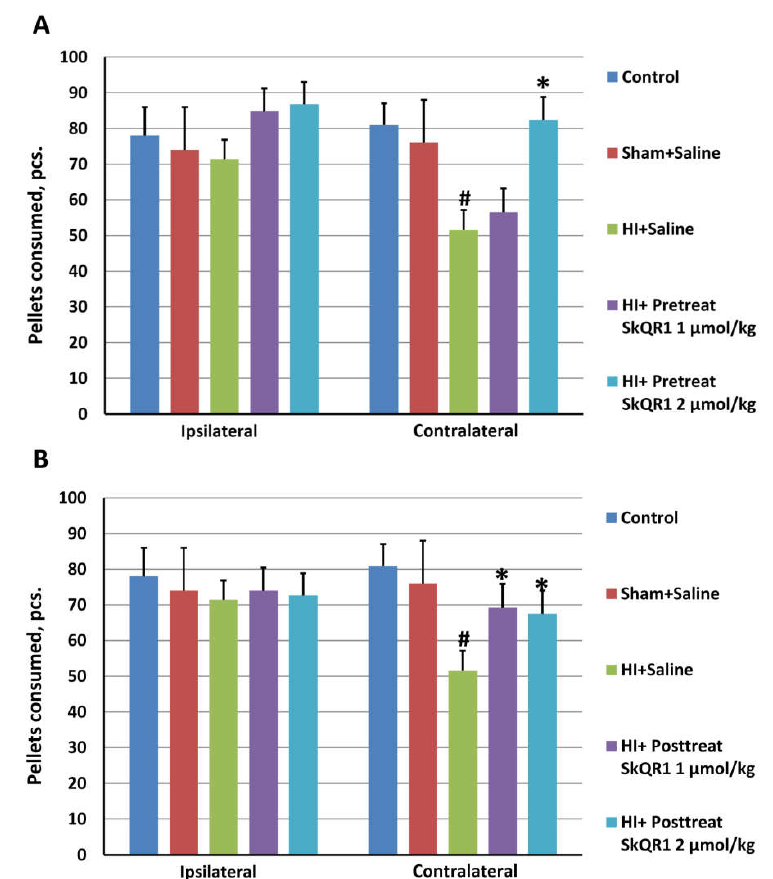
Figure 5. Effect of mitochondria-targeted antioxidant SkQR1 on a skilled motor task determined by the staircase test three months after the HI induction. SkQR1 was administrated i/p 24 h before HI ( A ) or 10 min after start of reoxygenation ( B ) at doses 1 and 2 µmol/kg. Results represent the amount of all consumed pellets during 10 days of testing for each side. Data are expressed as mean ± SEM. # p < 0.05 denotes significant difference between control with HI + Saline groups with ipsilateral side; * p < 0.05 denotes significant difference from HI + Saline group, one-way ANOVA, followed by Tukey’s post hoc analysis.